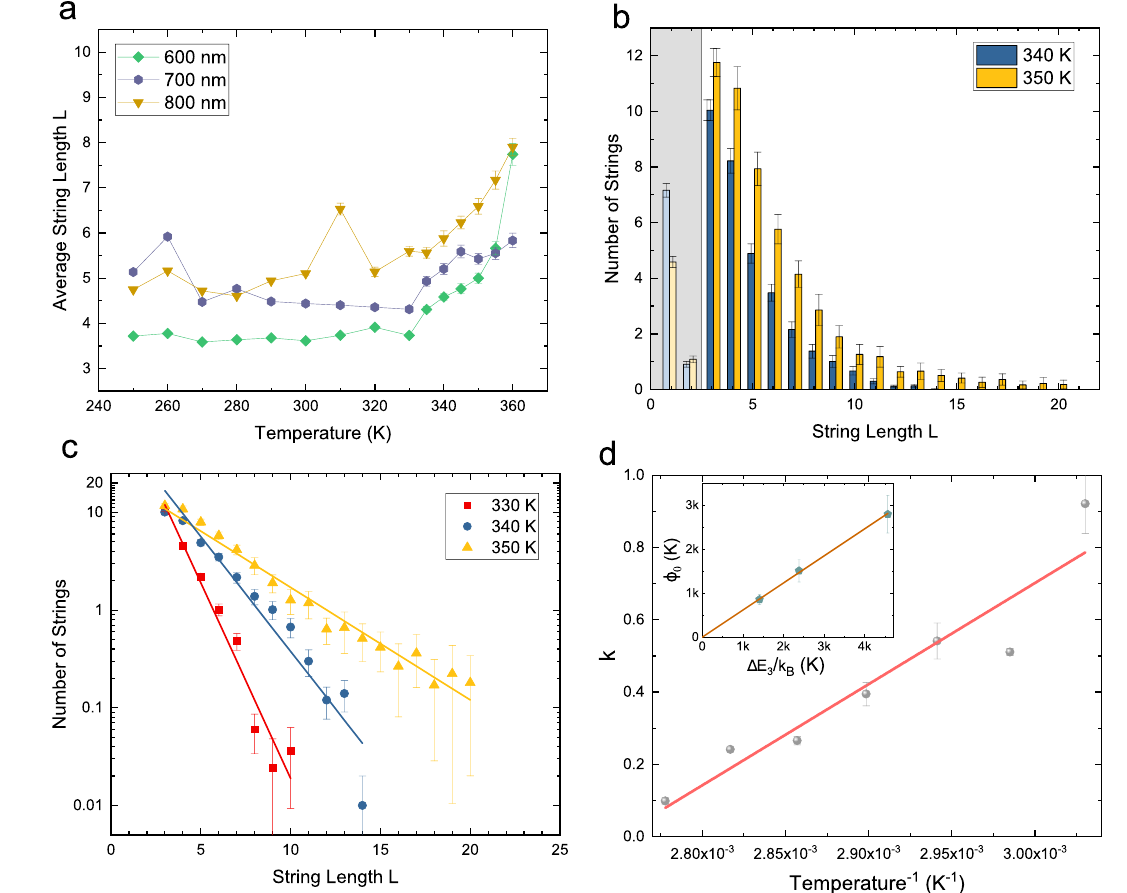
Fig. 4 String statistics from XMCD-PEEM data. a The average length of strings as a function of temperature from the XMCD-PEEM data (measured in numbers of unhappy vertices). Note that the average string length is fl at below T ≈ 330 K, indicating that the system falls out of thermal equilibrium. b The distribution of strings with various length for the a = 600 nm lattice, averaging over approximately 80 images (see Methods section). The grey section covers those strings that are connecting only contiguous interior plaquettes and therefore are expected to have a different energy scale. c The distribution of string length with a fi t to a Boltzmann distribution p ( L ) / e − Lk as described in the text. The error bars in panels ( a – c ) represent the standard errors of the data taken at each temperature. d The fi tted k from the Boltzmann distribution as a function of inverse temperature for a = 600 nm and 330 K ≤ T ≤ 360 K shows a linear dependence on the inverse temperature, k ( T ) = ϕ 0 / T − ϕ 1 . Inset: the fi t parameter ϕ 0 as a function of [ Δ E 3 / k B ] computed from micromagnetics for all three samples, where the error bars are the standard errors of the fi t